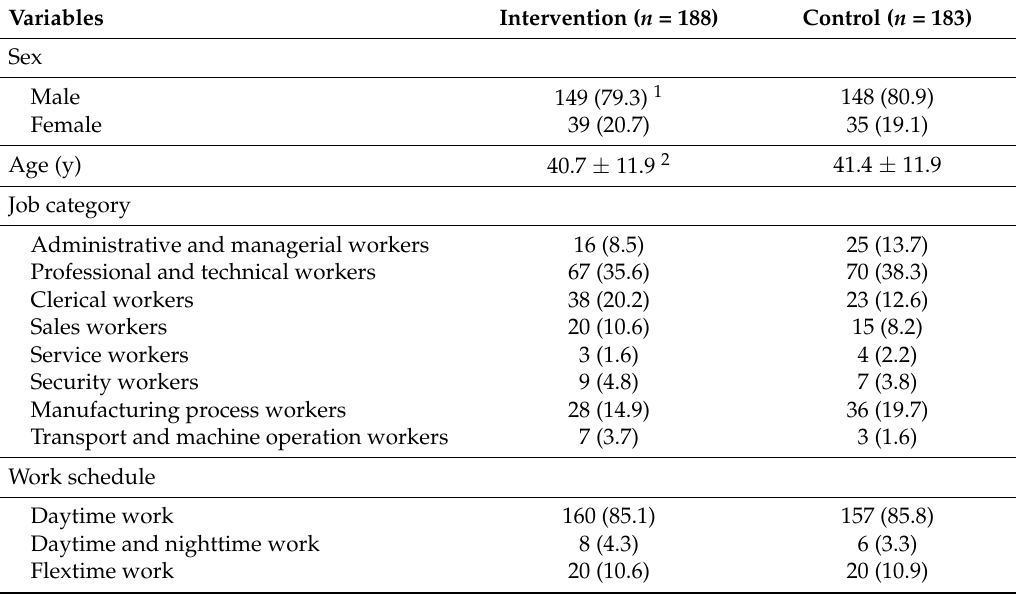
Table 1. Characteristics of participants at baseline.